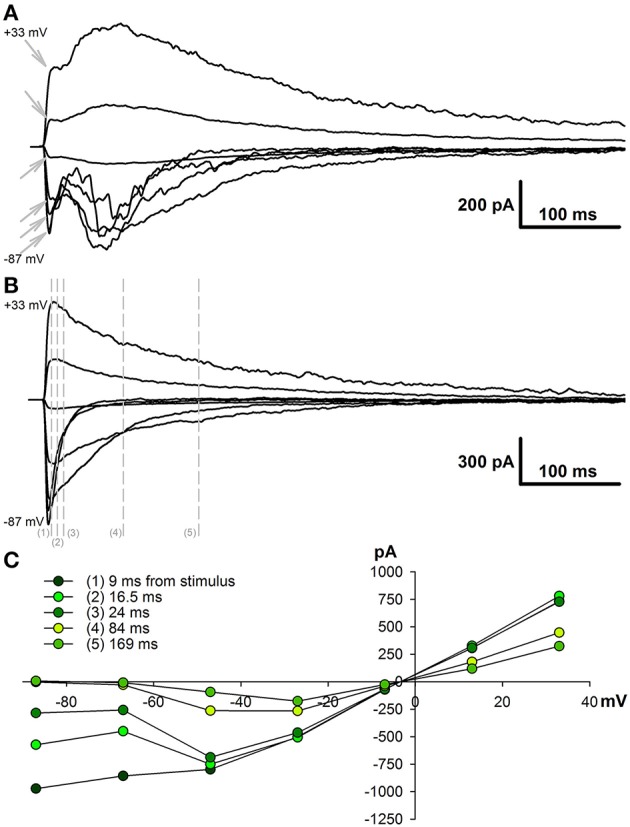
Evoked EPSCs in pyramidal cells of TC and hippocampus. (A) A representative example of evoked EPSCs recorded in the TC pyramidal cell in control rat at different holding voltages (from +33 to −87 mV with 20 mV increment). Stimulus artifacts were digitally subtracted. Note that the responses have clearly distinct monosynaptic peaks (marked with gray arrows). (B) Evoked EPSCs recorded in the CA1 pyramidal cell in control rat. Note the absence of polysynaptic components of the response. Vertical lines indicate the time points at which I–V relationships are shown in C. (C) I–V relationships obtained at different time point after stimulation. Note that at the beginning (9 ms from the stimulus) I-V is almost linear and is similar to AMPA channel I-V curve, later it resembles curve for the conductance elicited by NMDA receptors.